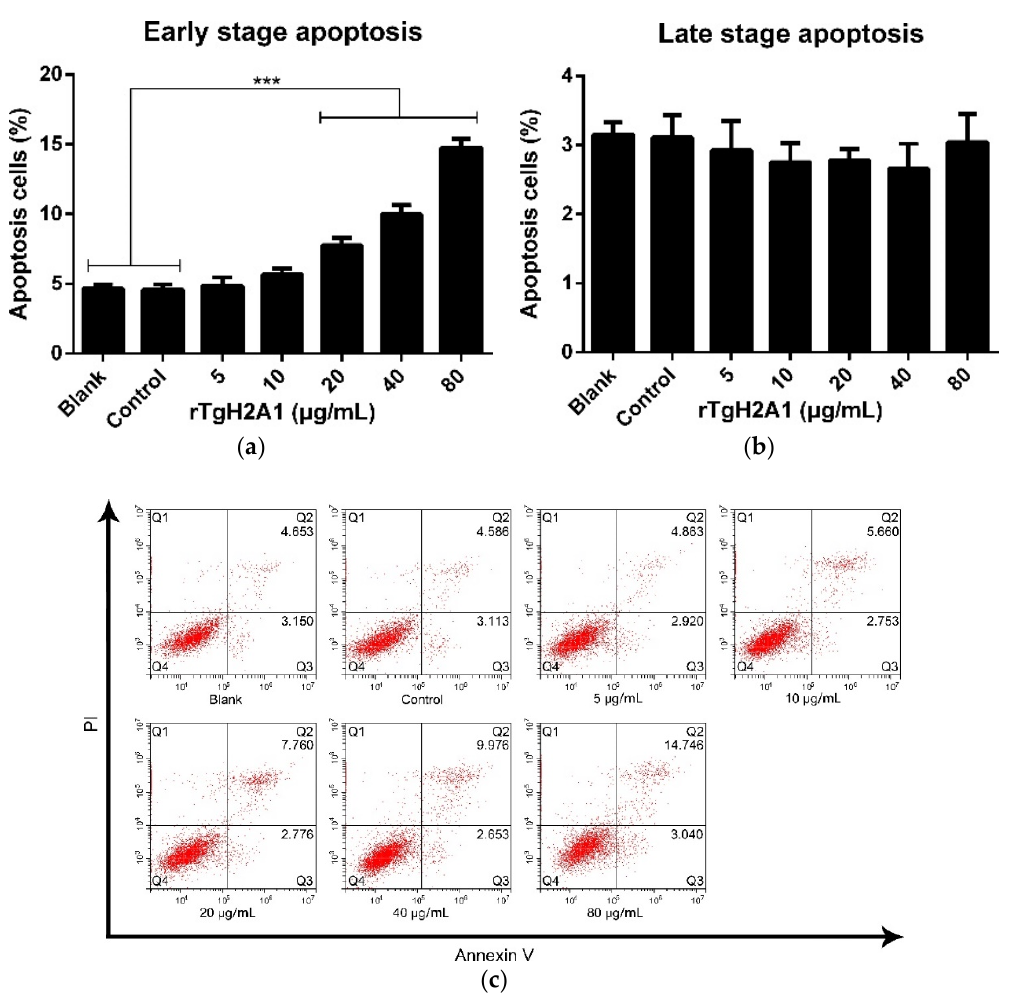
Figure 4. rTgH2A1 induced the apoptosis of murine Ana-1 cells. Ana-1 cells were preincubated with different concentrations (0, 5, 10, 20, 40, and 80 μg/mL) of rTgH2A1 for 48 h. Results were evaluated using one-way ANOVA analysis followed by Dunnett’s test and expressed as mean ± standard deviation of three independent experiments. *** p < 0.001 compared with the blank group or control group. Effect of rTgH2A1 on the early ( a ) and late ( b ) stage apoptosis of murine Ana-1 cells. Cells stained with Annexin V and PI were measured with flow cytometry ( c ).